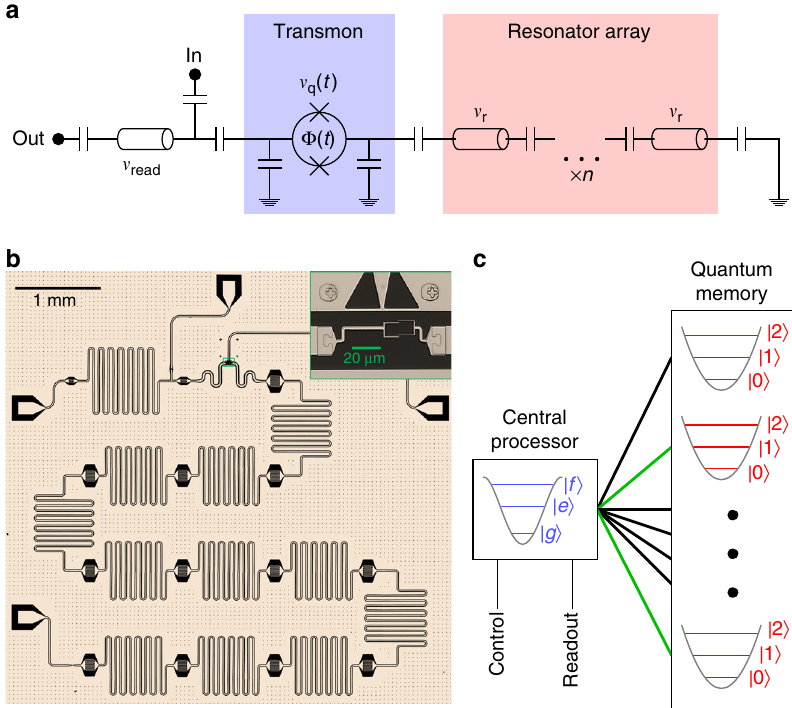
Fig. 1 Random access superconducting quantum information processor. a , b Schematic and optical image, respectively, of the superconducting microwave circuit. The circuit comprises an array of 11 identically designed, co-planar waveguide (CPW) half-wave resonators, capacitively coupled strongly to each other. The top end of the array is capacitively coupled to a tunable transmon qubit. The transmon is measured with a separate resonator, whose input line doubles as a charge bias for the transmon. The inset shows the tunable SQuID of the transmon, as well as its fl ux bias above it. c Random access with multiplexed control. The quantum memory consists of the eigenmodes of the array, with each mode accessible to the transmon. This allows for quantum operations between two arbitrary memory modes (such as those highlighted in green) via the central processing transmon and its control